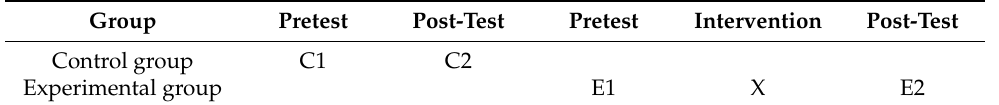
Table 1. Research design. Group Pretest Post-Test Pretest Intervention Post-Test Control